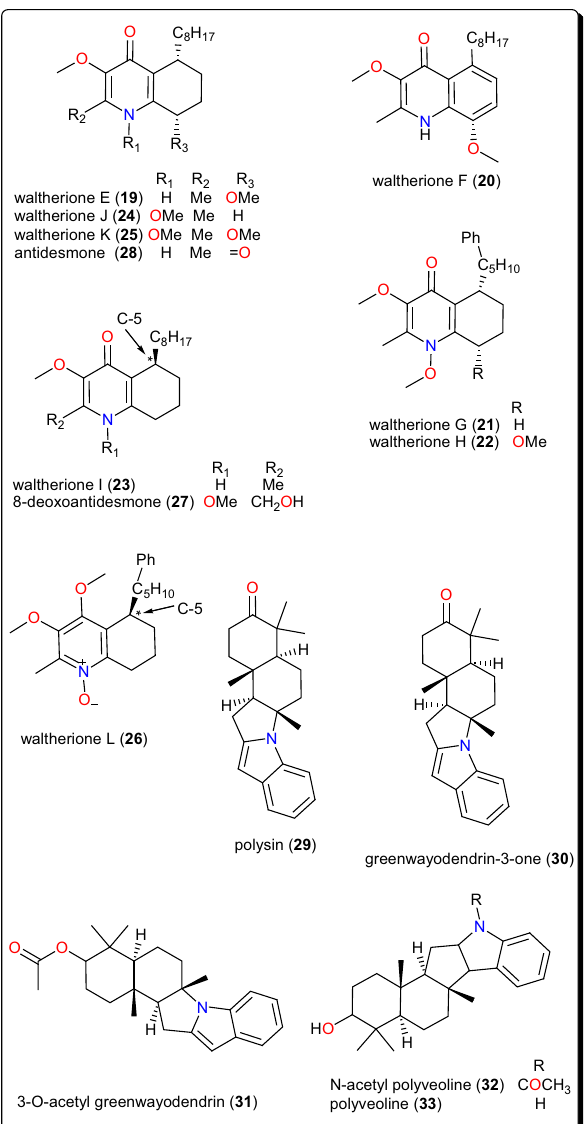
Fig. 4 Quinoline, indoles and other alkaloids showing activities against Trypanosoma